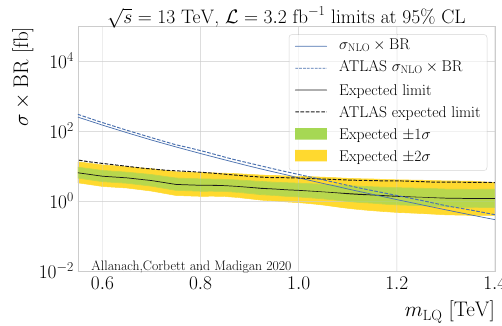
Fig. 12 Validation plot comparing our expected limits at 95% CL on σ × BR for LQ pair production and decay into a μμ jj final state at √ s = 13 TeV, L = 3 . 2 fb − 1 to the expected limits obtained by ATLAS